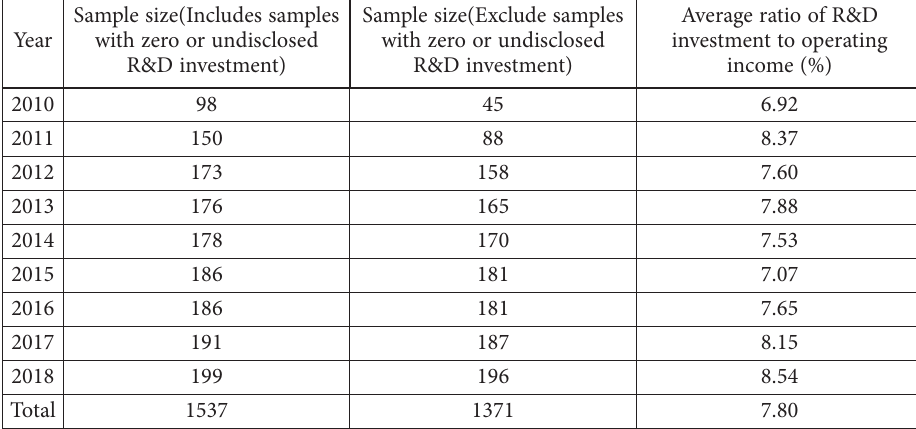
Table 1. Sample distribution Sample size(Includes samples Year with zero or undisclosed R&D investment)